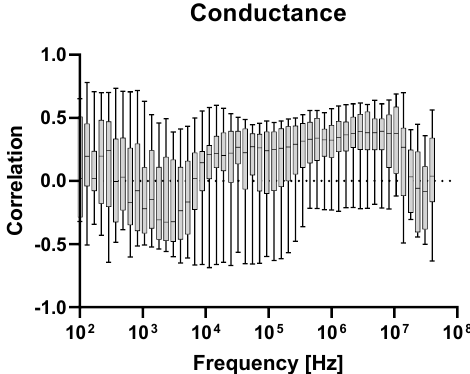
Fig.7: Correlation between measured conductance at different frequencies, and blood glucose level.